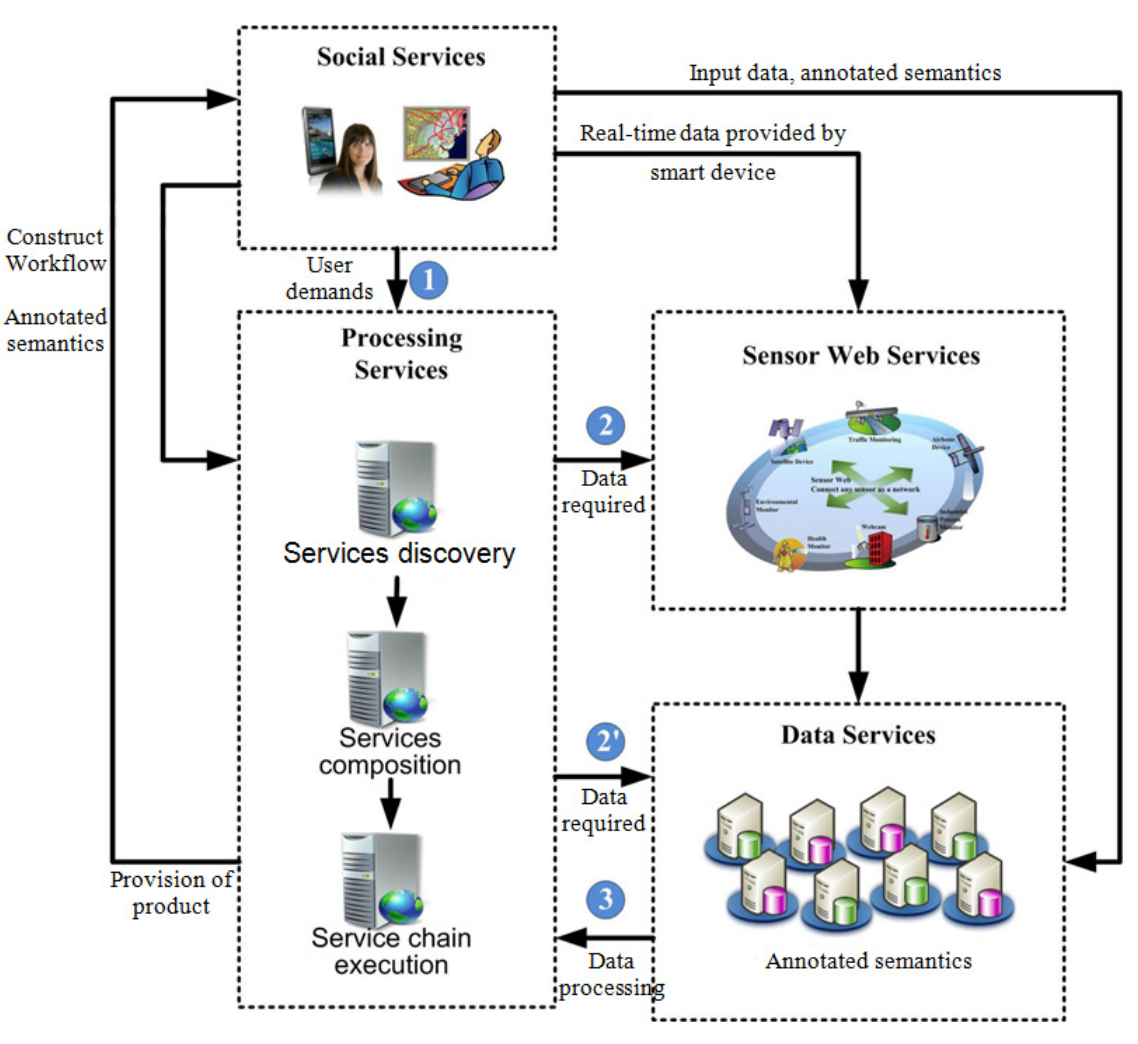
Figure 1. Workflow of